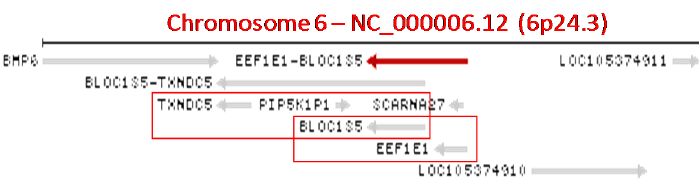
Figure 2. An image copied from the NCBI database illustrating that the BLOC1S5 gene and its upstream gene EEF1E1 on the minus strand of the 6p24.3 region together produce an EEF1E1 - BLOC1S5 RNA (red arrow to the left), while it and its downstream gene TXNDC5 together produce a BLOC1S5 - TXNDC5 RNA (the long grey arrow to the left). Note that there is no EEF1E1 - BLOC1S5 - TXNDC5 RNA shown in the image. Table 1. Some two-neighboring-gene RNAs of the human origin documented in the NCBI database.